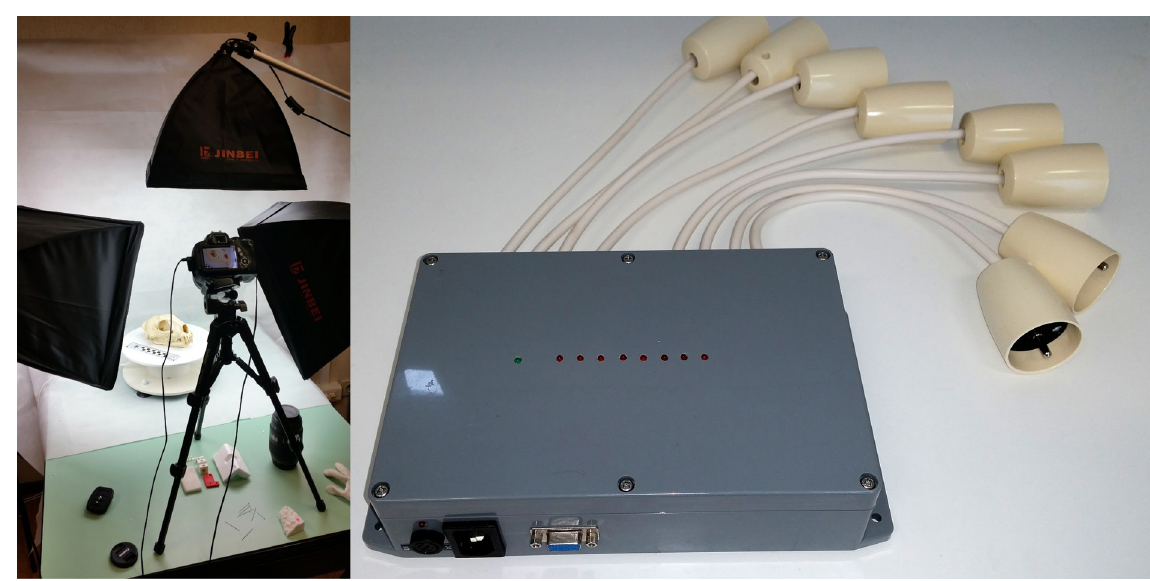
Fig. 3.4. The photogrammetry setup on the left with the automated turntable. The controller enables to command both a turntable and a camera through the AGORA 3D interface.